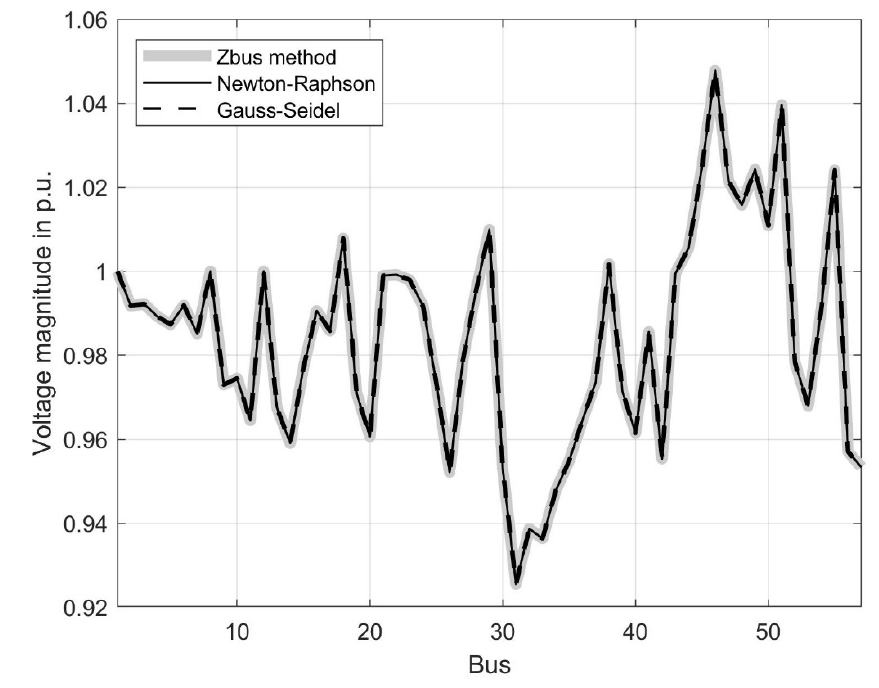
Figure 12. Voltage profile of the IEEE 57-bus system, in p.u.